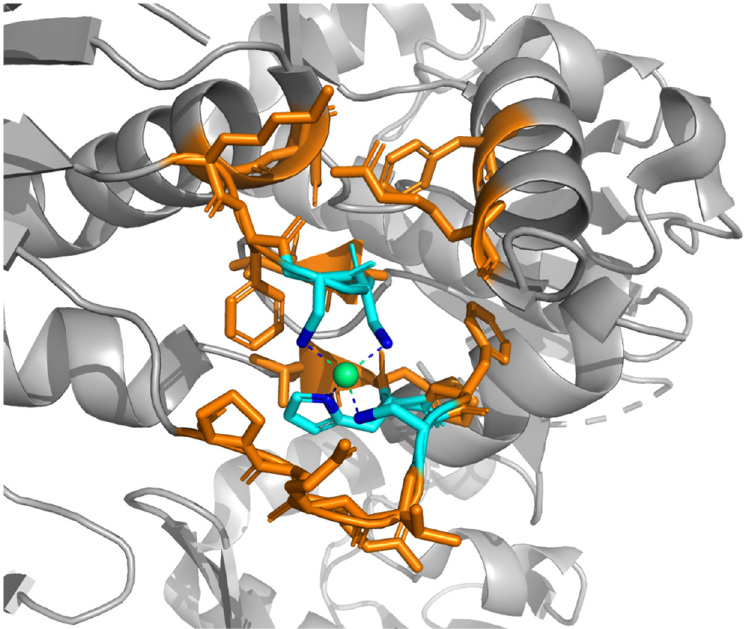
Figure 1. Definition of a MBS according to the MetalPDB protocol. For each metal atom in a given 3D structure, the non-hydrogen non-carbon atoms at a distance smaller than 3.0 Å from the metal ion (green sphere) are identified as its donor atoms (blue atoms), i.e., the atoms that bind directly to the metal. The protein residues or small molecules that contain at least one donor atom are the metal ligands (cyan sticks), and constitute the first coordination sphere of the metal ion. The full MBS is obtained by including any other residue or chemical species with at least one atom within 5.0 Å from a metal ligand (orange sticks). Metal ligands provided by small molecules (e.g., water, ammonia, synthetic inhibitors) or ions (e.g., acetate, hydroxamate) are called exogenous ligands. This example MBS is the zinc(II)-binding site of human Schlafen 5 protein (PDB entry 7Q3Z [31]).